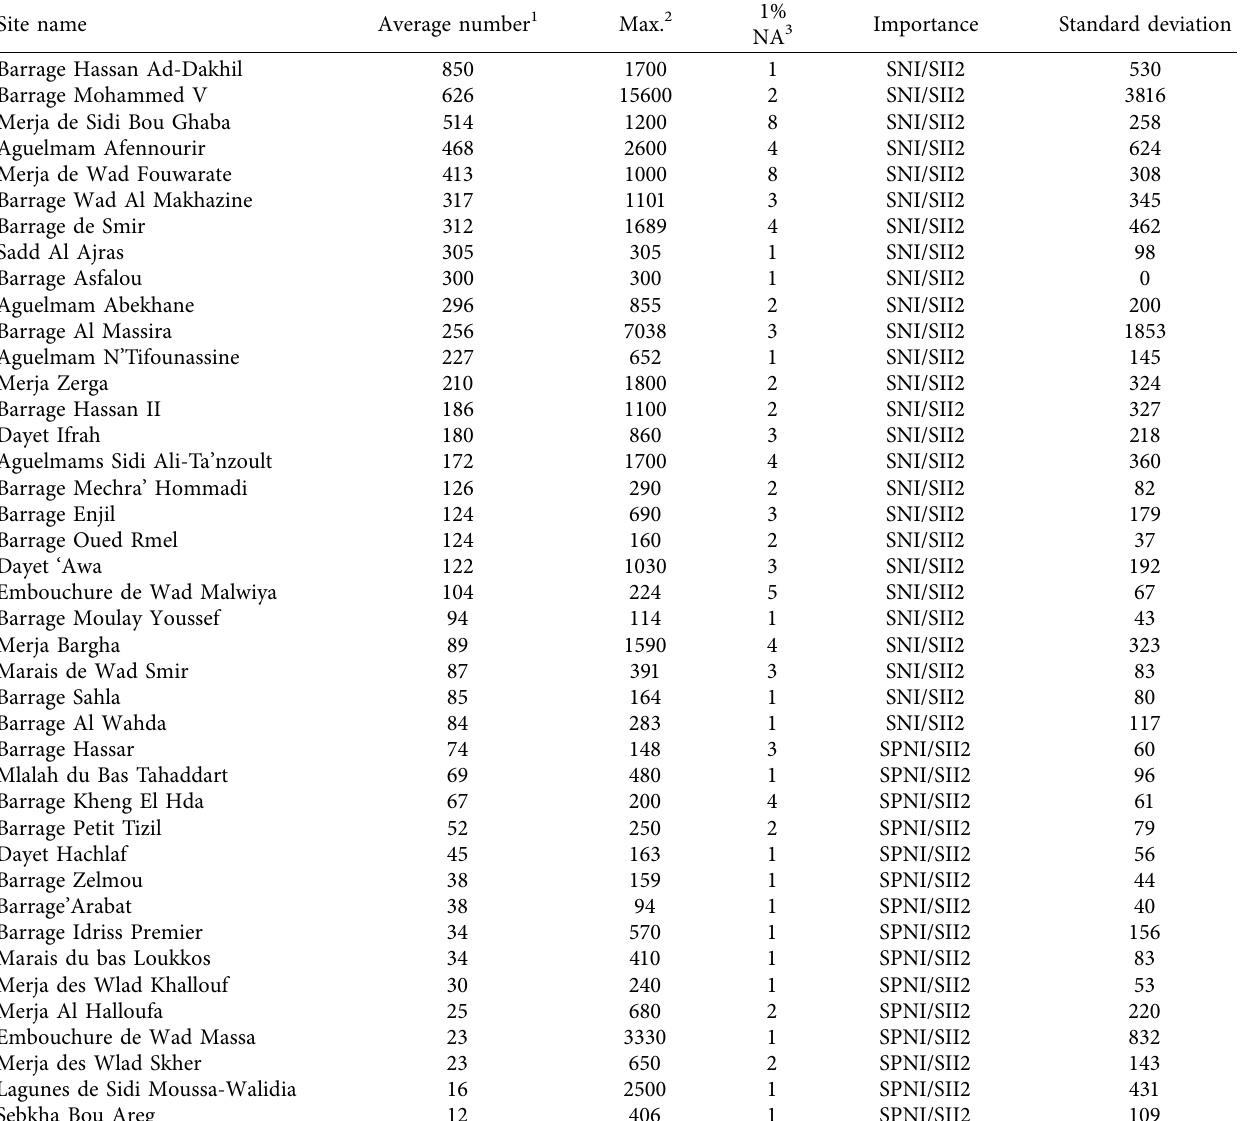
Table 2: Most important wintering sites of the Common Pochard